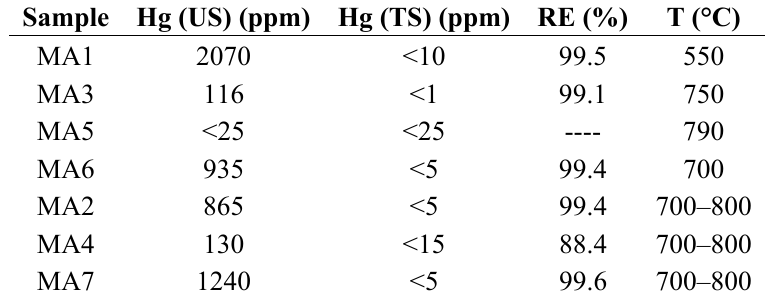
Table 4. Results of mercury removal by solar thermal desorption with the rotary kiln. US, untreated sample; TS, treated sample; RE, removal efficiency; T, mean temperature